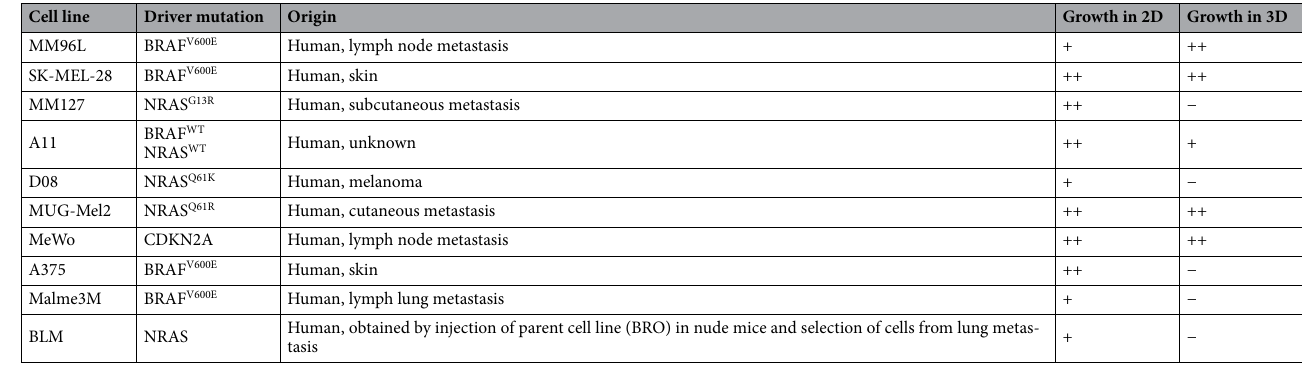
Table 1. Tested melanoma cell lines. Ten different melanoma cell lines were used to generate melanoma skin models. Differences were observed in their growth properties in 2D and 3D. Although all cells could be cultured in 2D, only 5 cell lines formed tumors in the 3D models. Growth in 2D: ++ normal cell growth; + slower growth. Growth in 3D: ++ ratio melanoma cells to keratinocytes 1:100; + ratio melanoma cells to keratinocytes higher than 1:100; – not detectable in the 3D